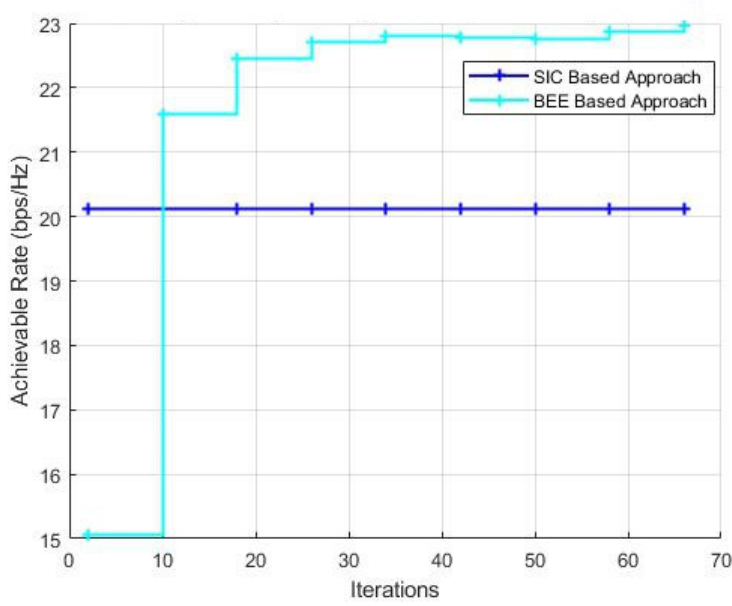
Figure 10. Simulations with N T = 144, N R = 36, N rf = 9, population = 70.